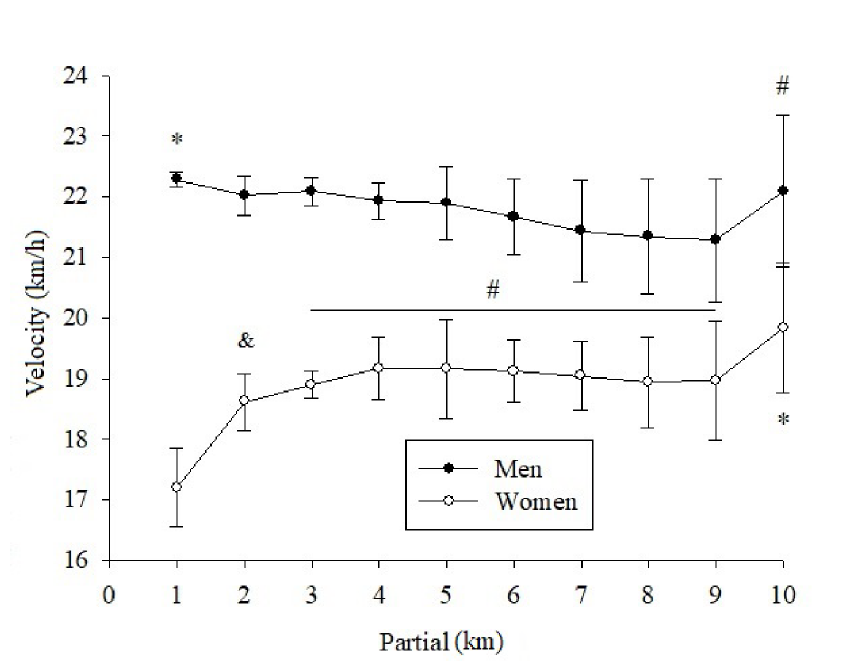
Figure 1 - Running velocity from male and female groups during the 10,000 m race. Male: (*) greater than 4, 5, 6, 7, 8, and 9 km. (#) higher than 6, 7, 8, and 9 km. Female: (*) greater than 1-9 km. (#) greater than 1 and 2 km. (&) greater than 1